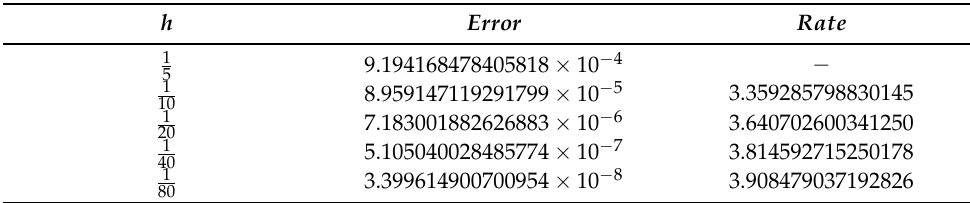
Table 3. Maximum errors and decay rate as functions with h . h